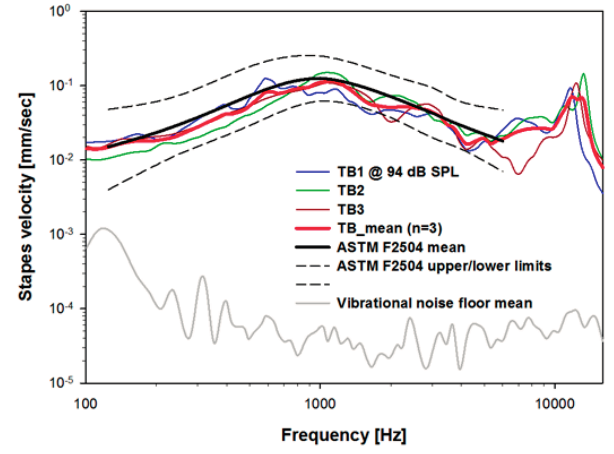
Figure 5. Stapes velocity for approximately 94 dB SPL sound drive at the entrance of the artificial ear canal in TB1-3 and their mean. The ASTM F2504 standard response is shown for comparison. The noise floor was measured without a sound drive.